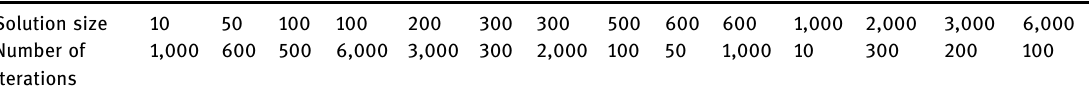
Table 3: Solution size and number of